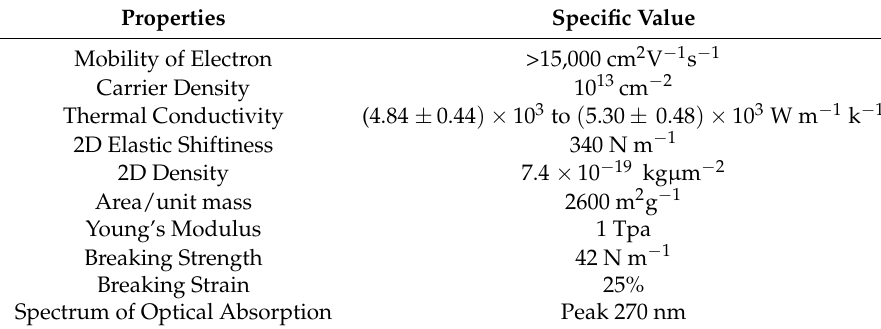
Table 1. Sensing properties of